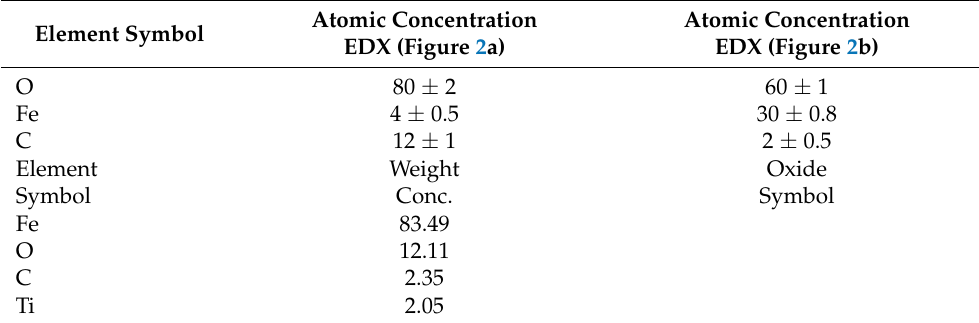
Table 1. Average atomic concentration of the main elements as determined by EDX analysis reported in Figure 2a,b.